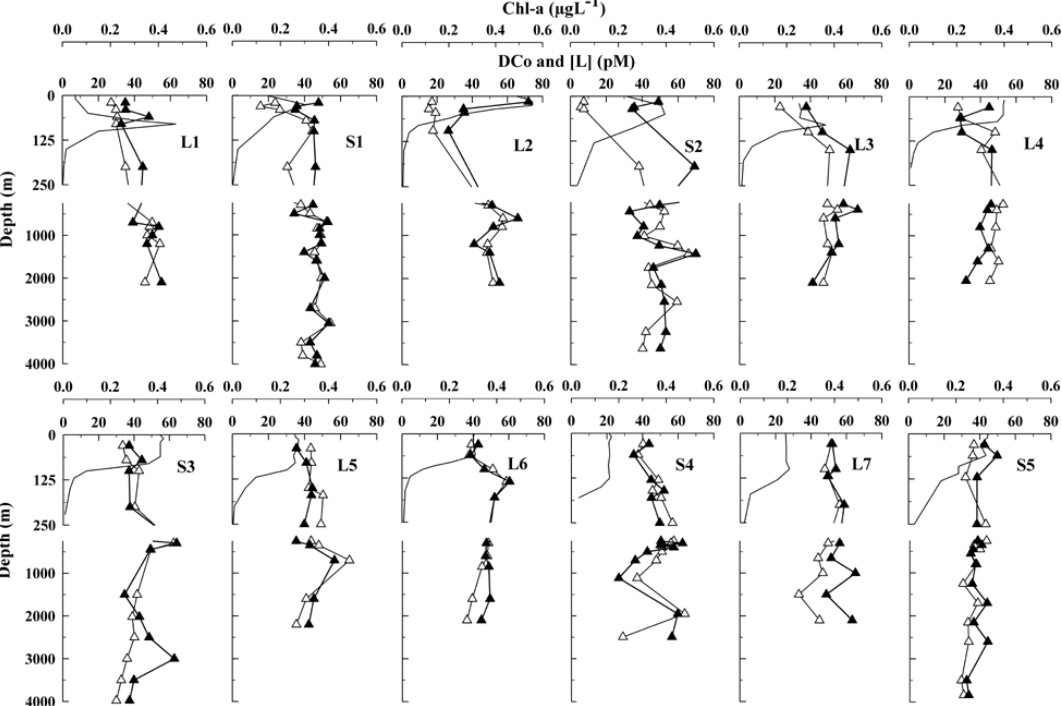
Fig. 3. Vertical distribution of the organic cobalt-binding ligands (L: black triangle), dissolved cobalt (DCo: white triangle; Bown et al., 2011), and Chlorophyll a (Chl a : solid line) at the LARGE and SUPER stations during the MD166 BONUS-GoodHope cruise. Chlorophyll a data from Gu´eneugu`es and Boye (2008).